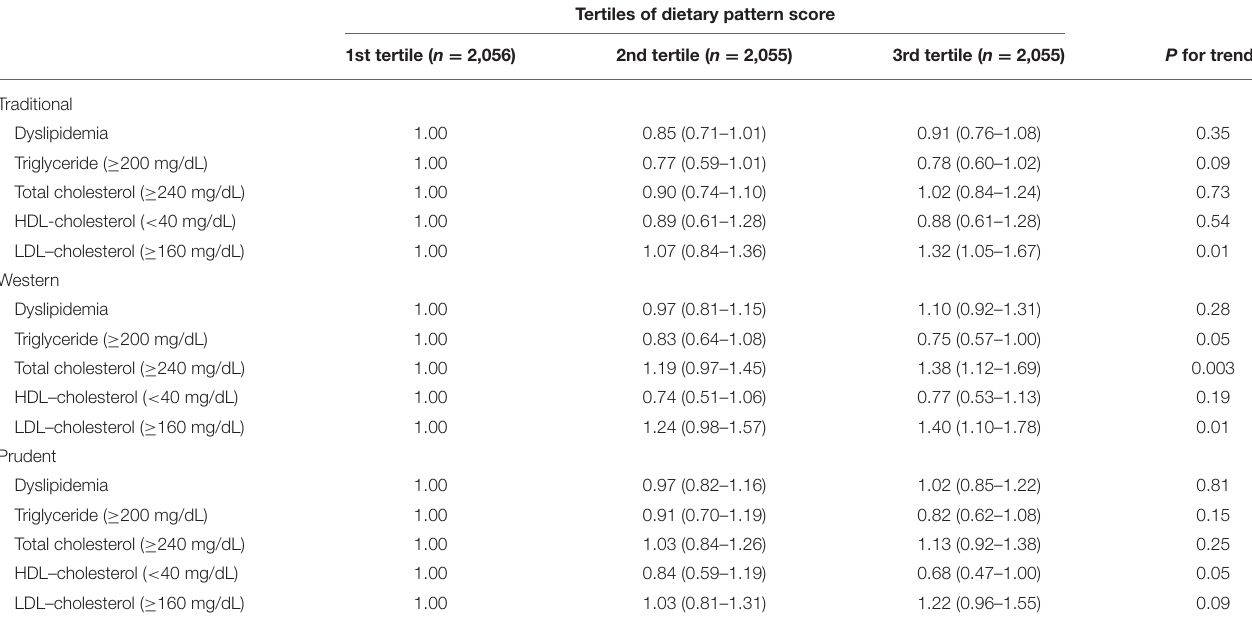
TABLE 5 | Odds ratios and 95% confidence intervals for the association between tertiles of dietary pattern score and the dyslipidemia and its components in women. Tertiles of dietary pattern score 1st tertile ( n =